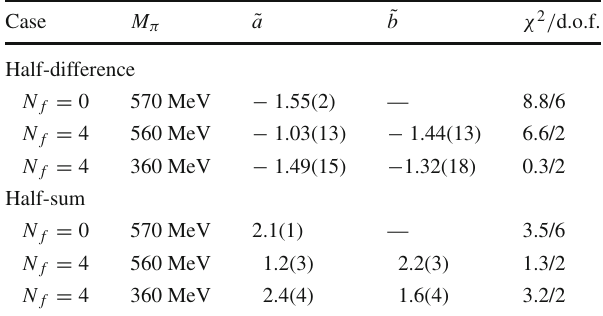
Table 5 Summary of results for the 1 / N c fits to the half-sum and half- difference of the amplitudes A ± . Errors are only statistical